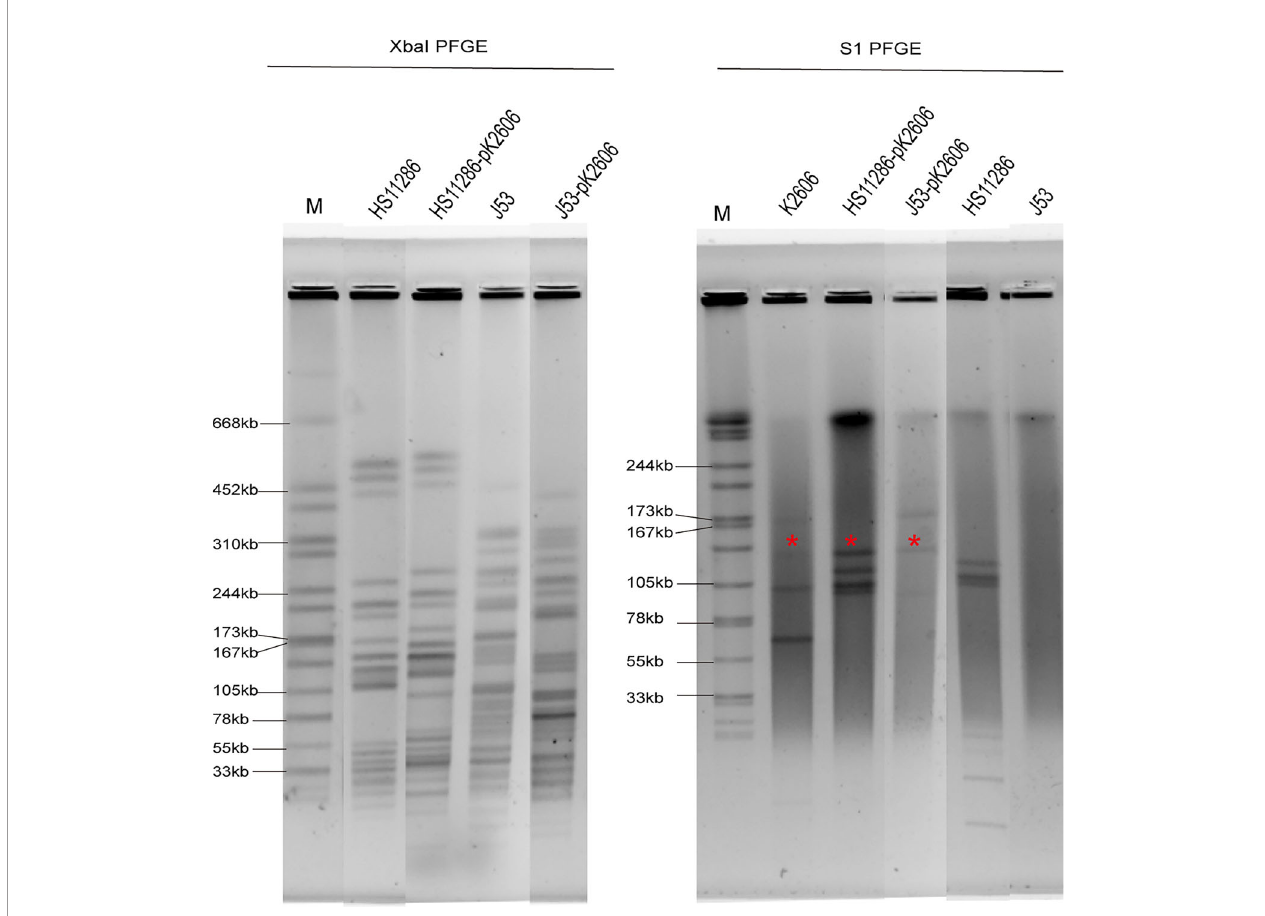
FIGURE 1 | XbaI PFGE and S1-PFGE of strains and corresponding transconjugants. *Virulence plasmid pK2606. The same symbol is used to represent the parental strain and its